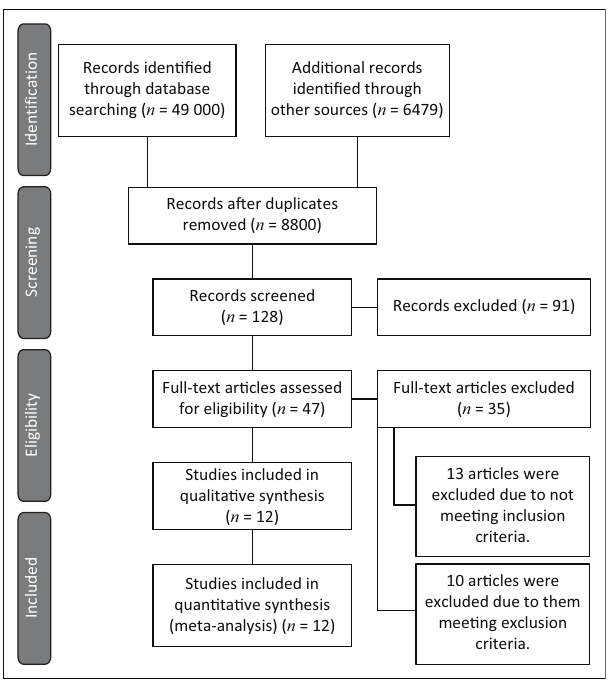
FIGURE 1: PRISMA-ScR flow diagram of results.